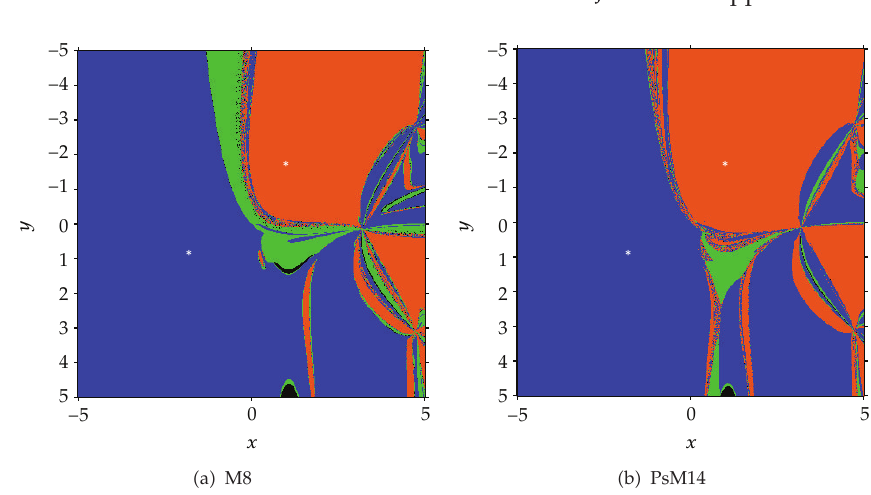
Figure 5: Real dynamical planes for system F 3 (cid:4) x (cid:5) (cid:6) 0 and methods M8 and